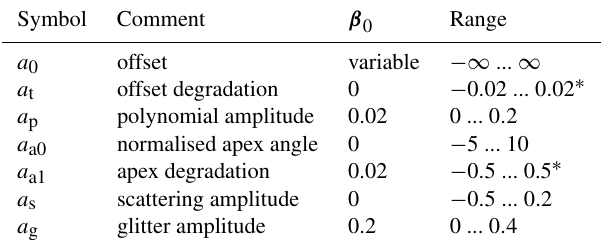
Table 5. List of T min model parameters with initial values ( β 0 ) and parameter bounds of the constrained non-linear